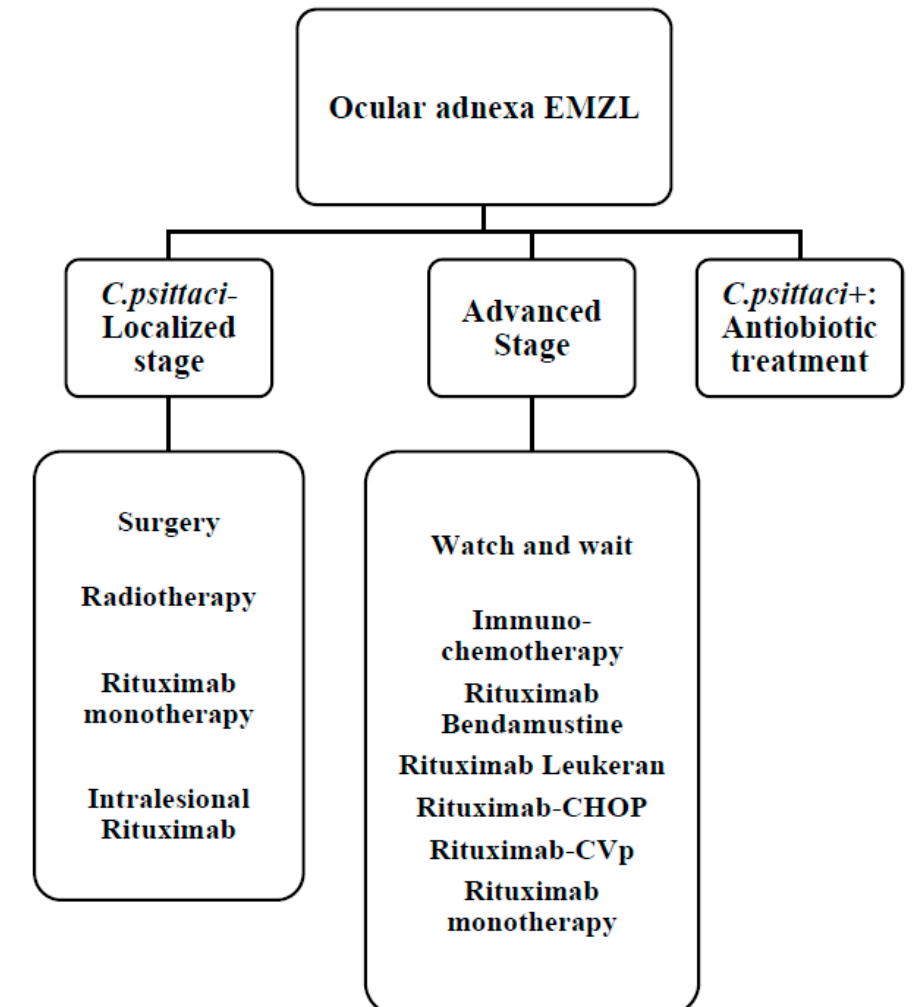
Figure 4. Therapeutic algorithm for ocular adnexa EZML. C. psittaci , Chlamidophila psittaci ; R-CHOP, Rituximab, Cyclophosphamide, Vincristine, Adriblastine, Prednisone; R-CVP, Rituximab, Cyclophos- phamide, Vincristine, Prednisone.